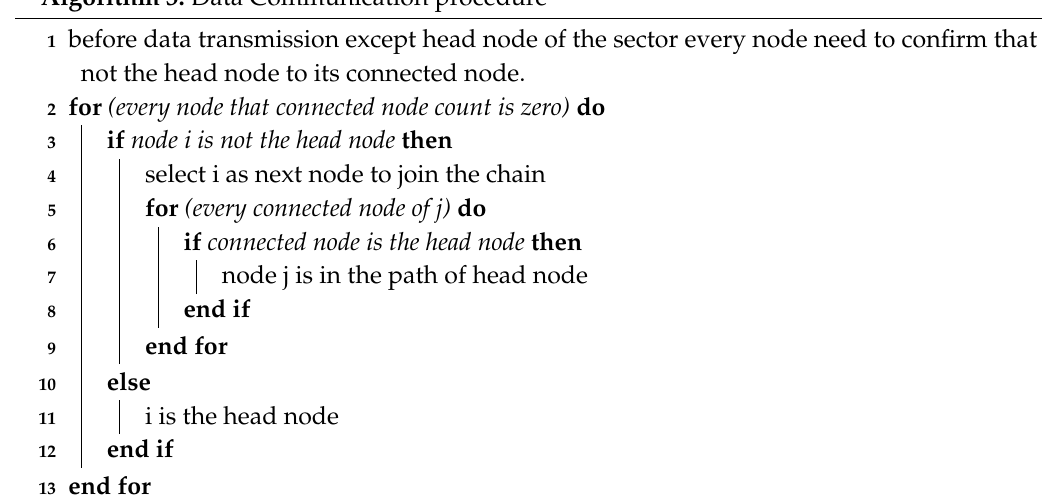
Algorithm 3: Data Communication procedure